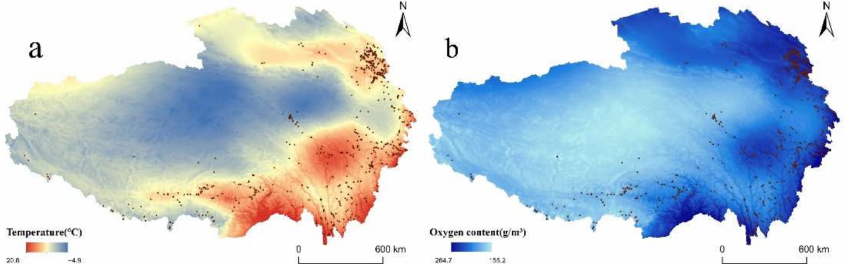
Figure 8. Spatial distribution of RT villages coupled with climate: ( a ) temperature; ( b ) oxygen